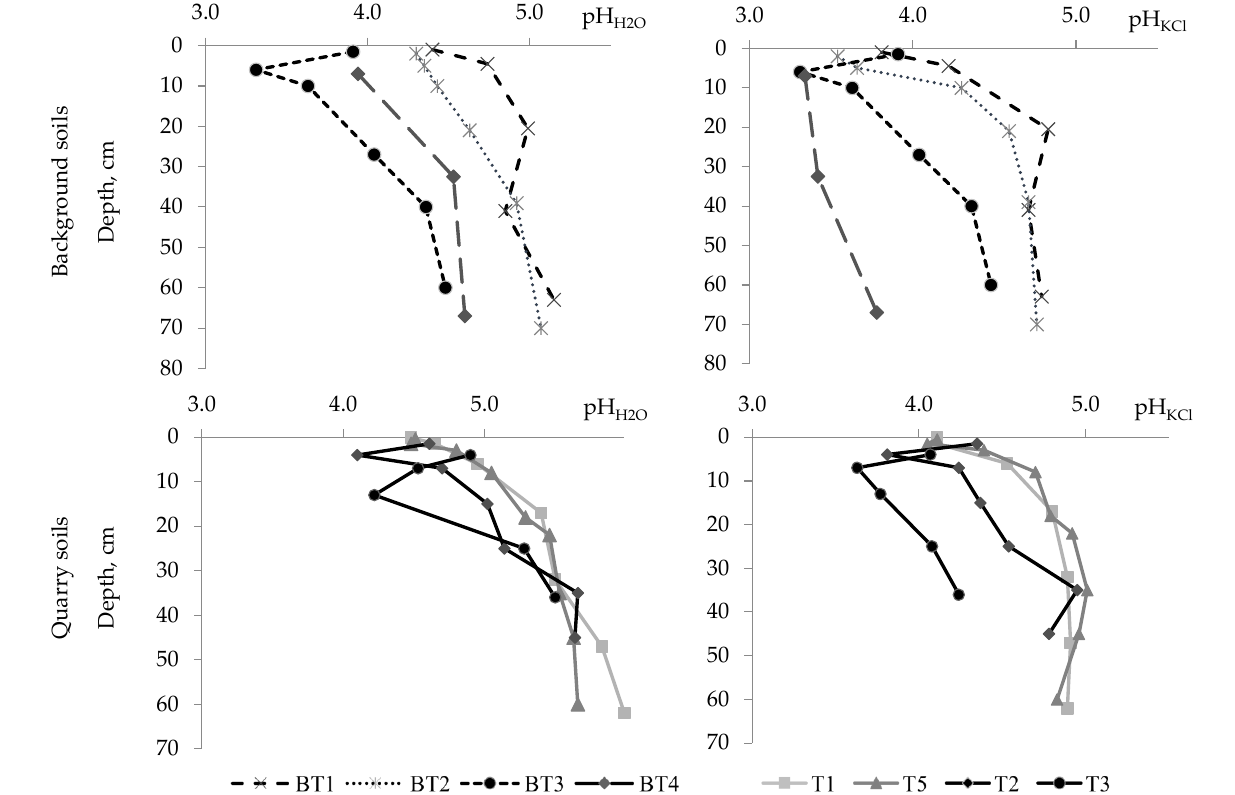
Figure 3. The profile distribution of pH H2O and pH KCl values in the background and quarry soils. All abbreviations are explained at Table 1. Forests 2022 , 13 , x FOR PEER REVIEW